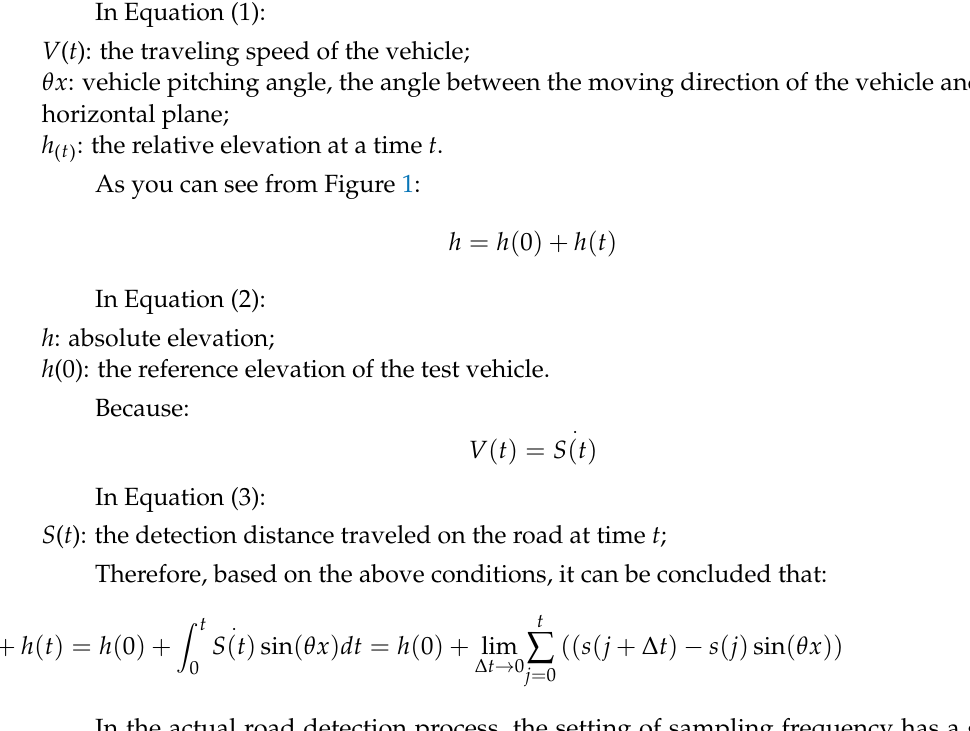
Figure 1. Working principle of road undulation elevation